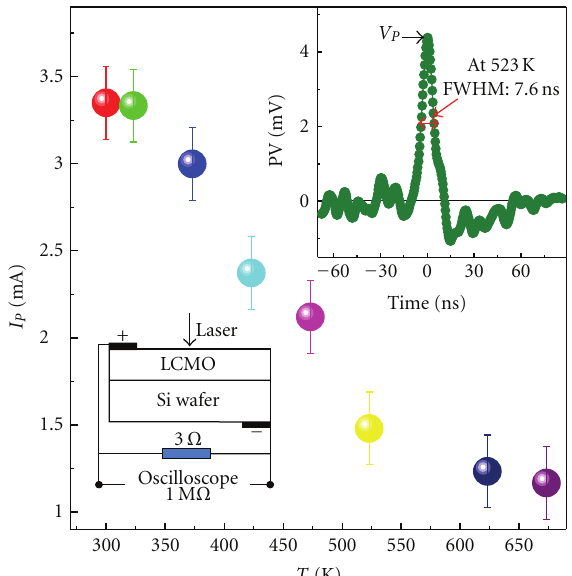
Figure 3: The photocurrent peak value I P as the measurement temperature. The upper inset shows PV pulse at 523 K under 248 nm pulse laser irradiation. The lower inset displays the schematic measurement circuits with a 3 Ω resistance connected in parallel with the detector.